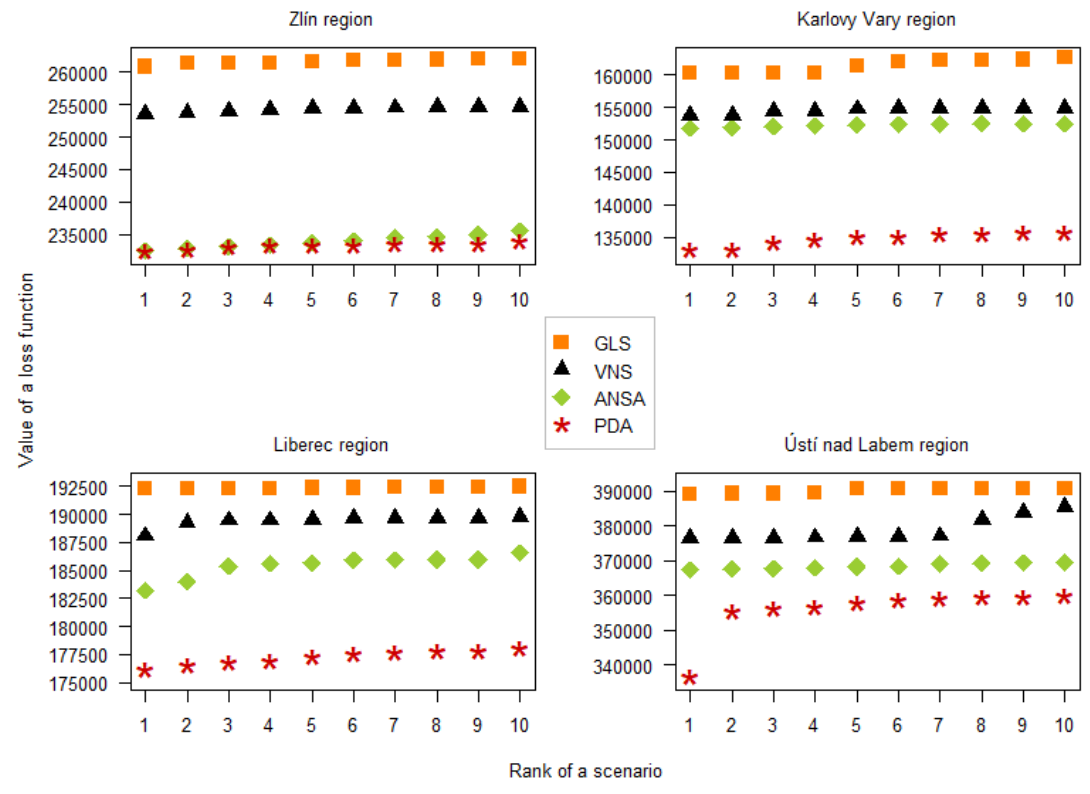
Figure 2. Values of the ten most critical scenarios for four concurrently interrupted